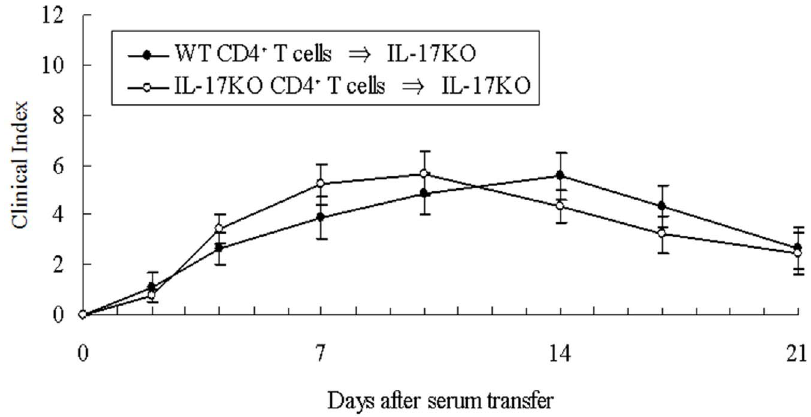
N Figure 5. CD4 + T cells do not aggravate K/BxN serum-induced arthritis. CD4 + T cells (1 6 10 7/ body) collected from spleen of IL-17 KO ( # ) or ) mice were injected into IL-17 KO mice at day 0. K/BxN sera (200 m l/body) were injected at days 0 and 2. Clinical index of arthritis is shown. The WT ( results were from two independent experiments, both of which showed similar results. n=9 mice in each group. doi:10.1371/journal.pone.0062231.g005 PLOS ONE | www.plosone.org